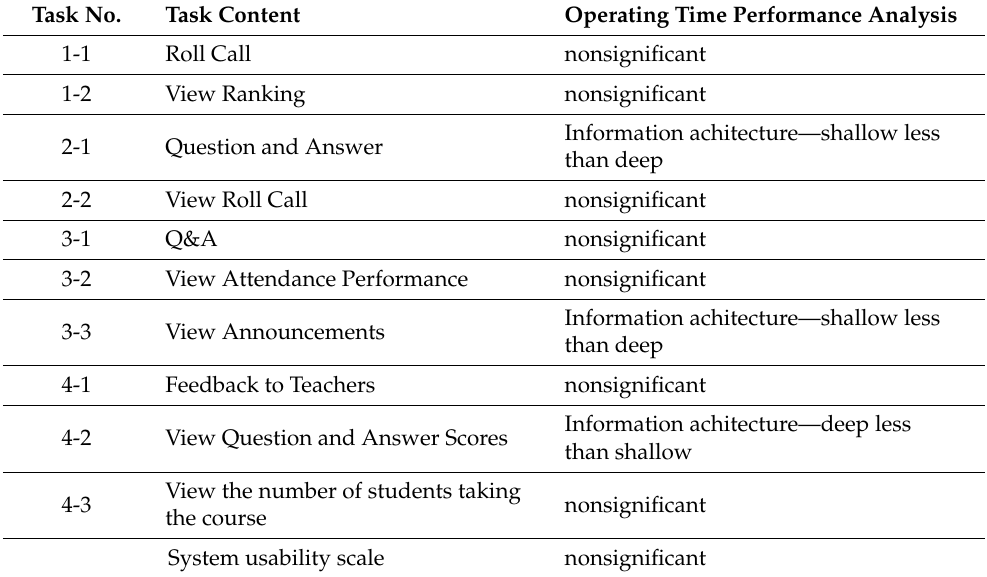
Table 7. Two-way ANOVA analysis summary